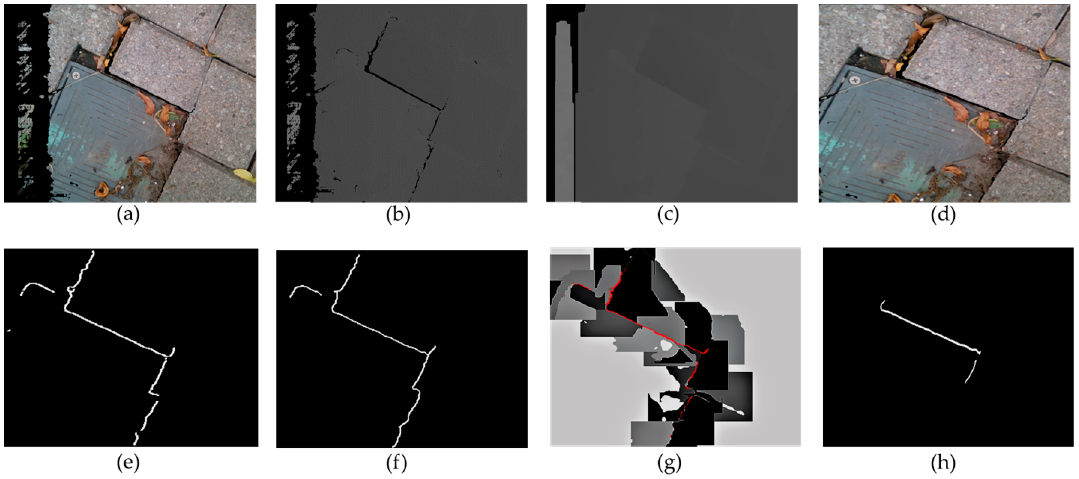
Figure 2. Visualization of each step of the crack detection algorithm showing ( a ) the original tripping hazard in the sidewalk, ( b ) the depth map of the captured frame, ( c ) the filtered depth map, ( d ) the Region of Interest (ROI), ( e ) the edges using Canny Edge Detection Algorithm, ( f ) edges after removing small edges and filling in small gaps between edges, ( g ) the image after segmentation in shades of gray and the true edges shown by the red line, ( h ) the final detection of the tripping hazard.